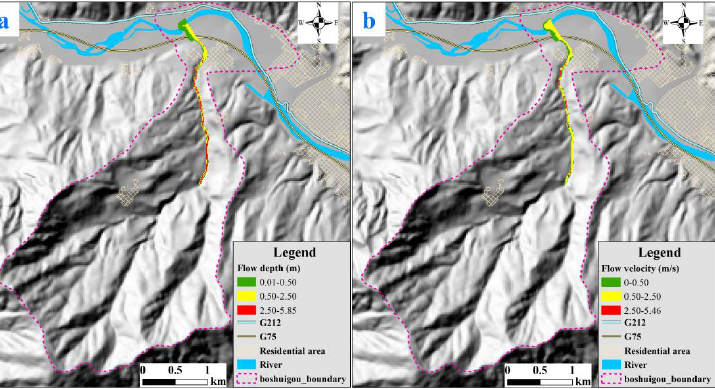
Figure 8. Flow depth ( a ) and flow velocity ( b ) of the Boshuigou debris flow under the 100-year return-period rainfall. Table 4. Simulation result of the Boshuigou debris flow under different return-period rainfalls.